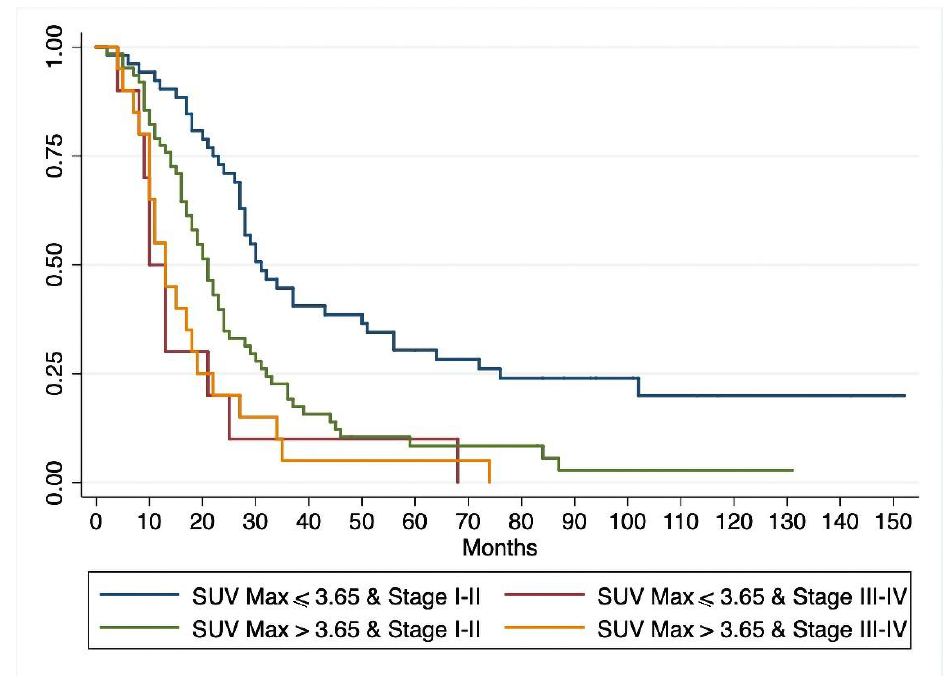
Figure 5. Kaplan-Meyer curves for overall patient survival by preoperative stage and SUVmax category.